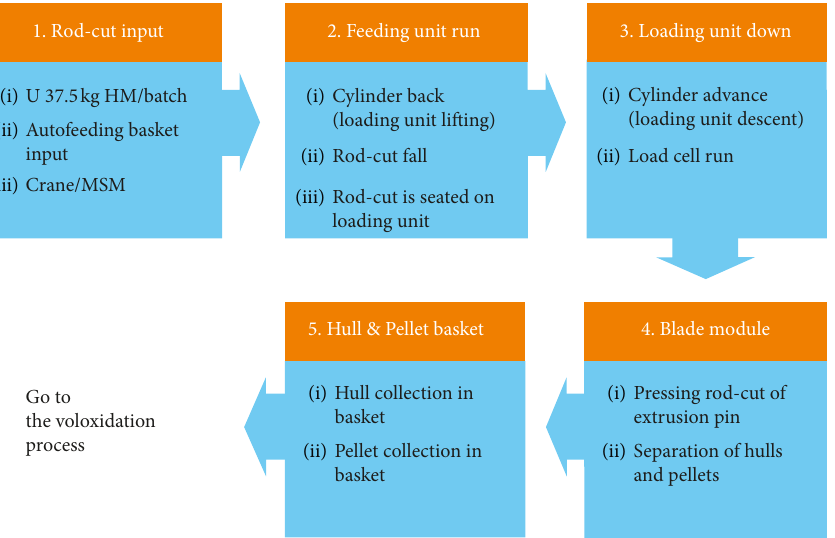
Figure 21: Operating procedure of mechanical